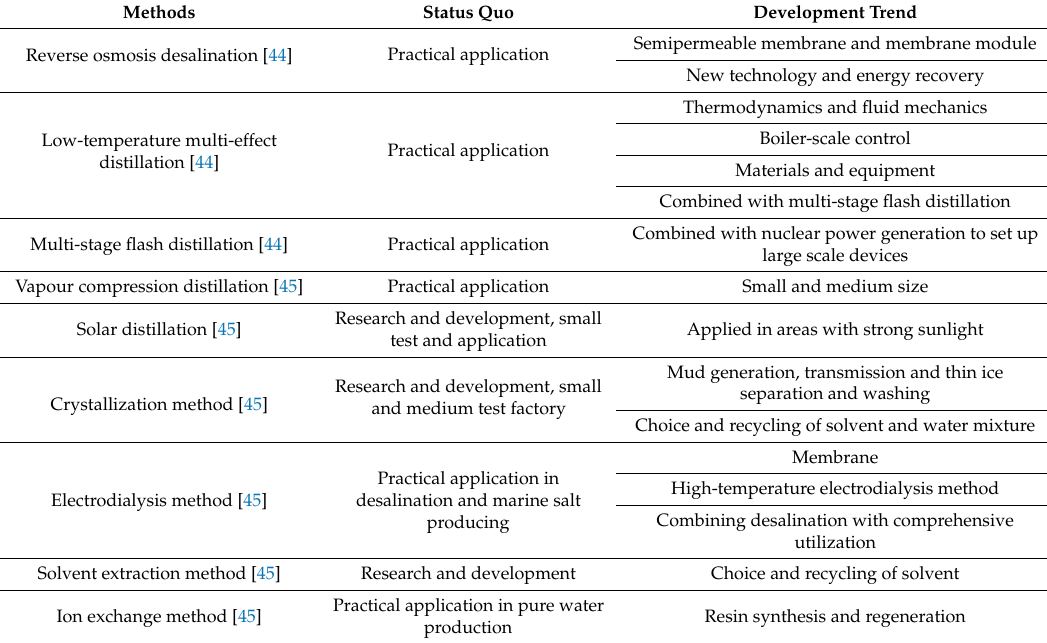
Table 1. Main desalination methods and development trends in